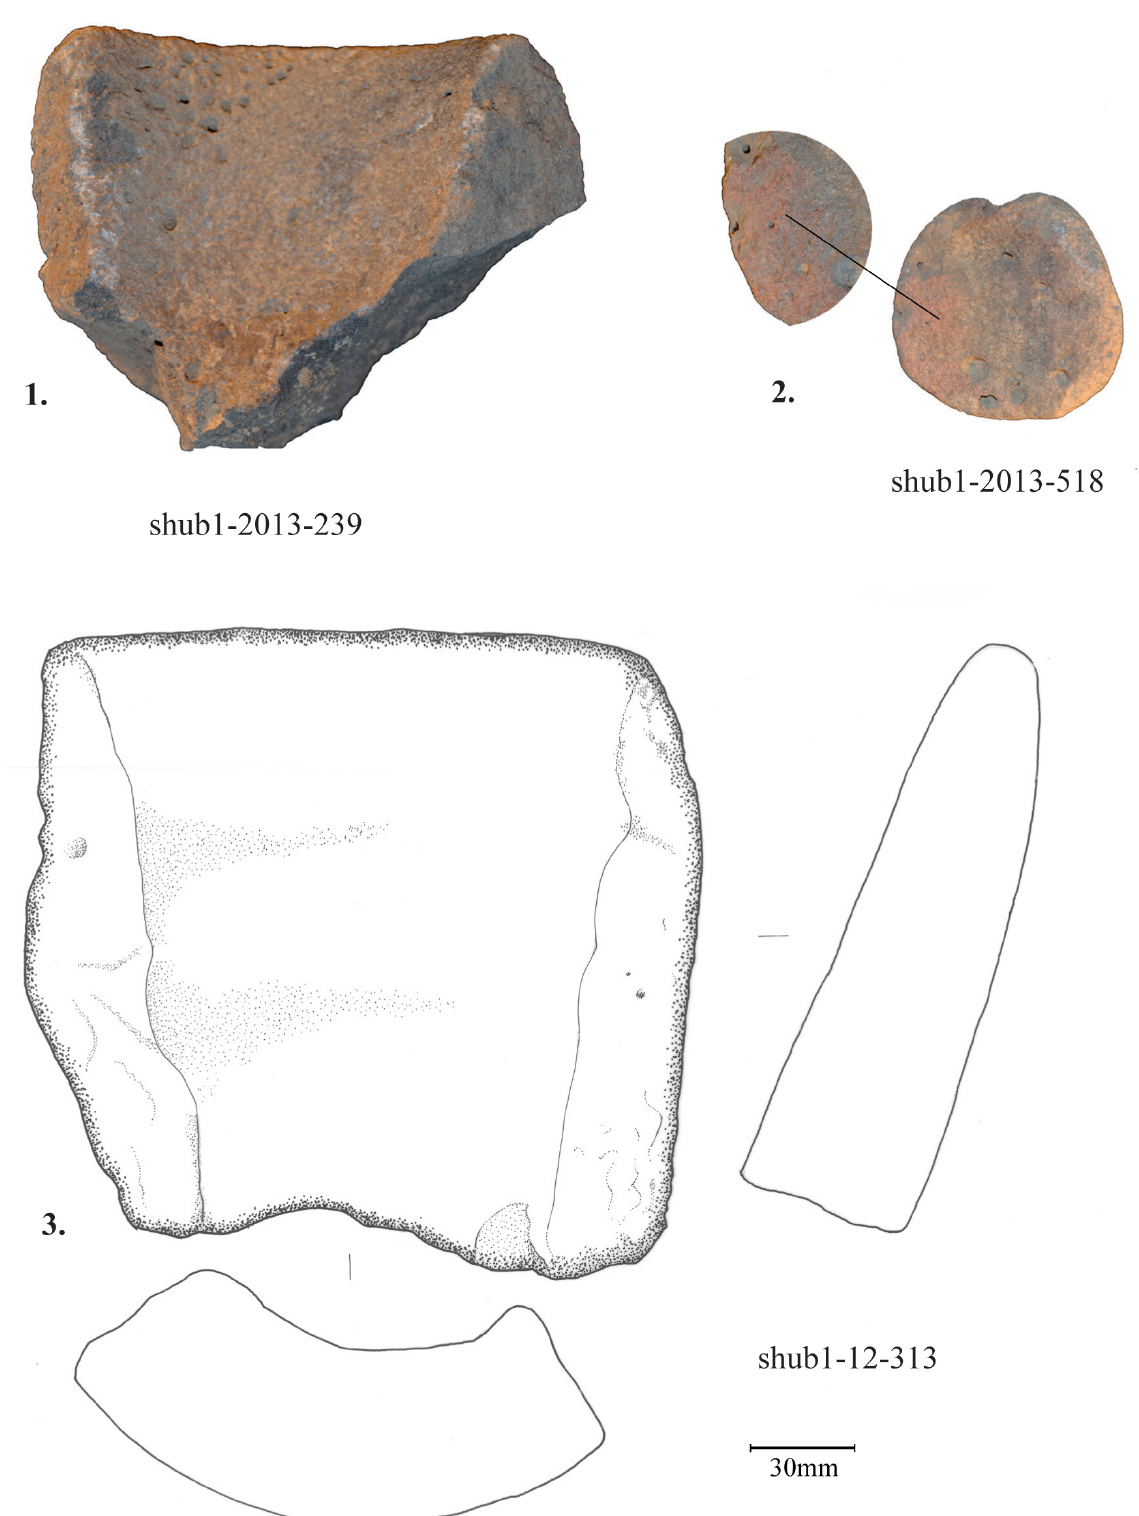
Figure 10: Mortars. No. 1: Fragment of globular type vessel-mortar, No 2: Complete plate or palette stained by ochre, No. 3: Fragment of goblet type